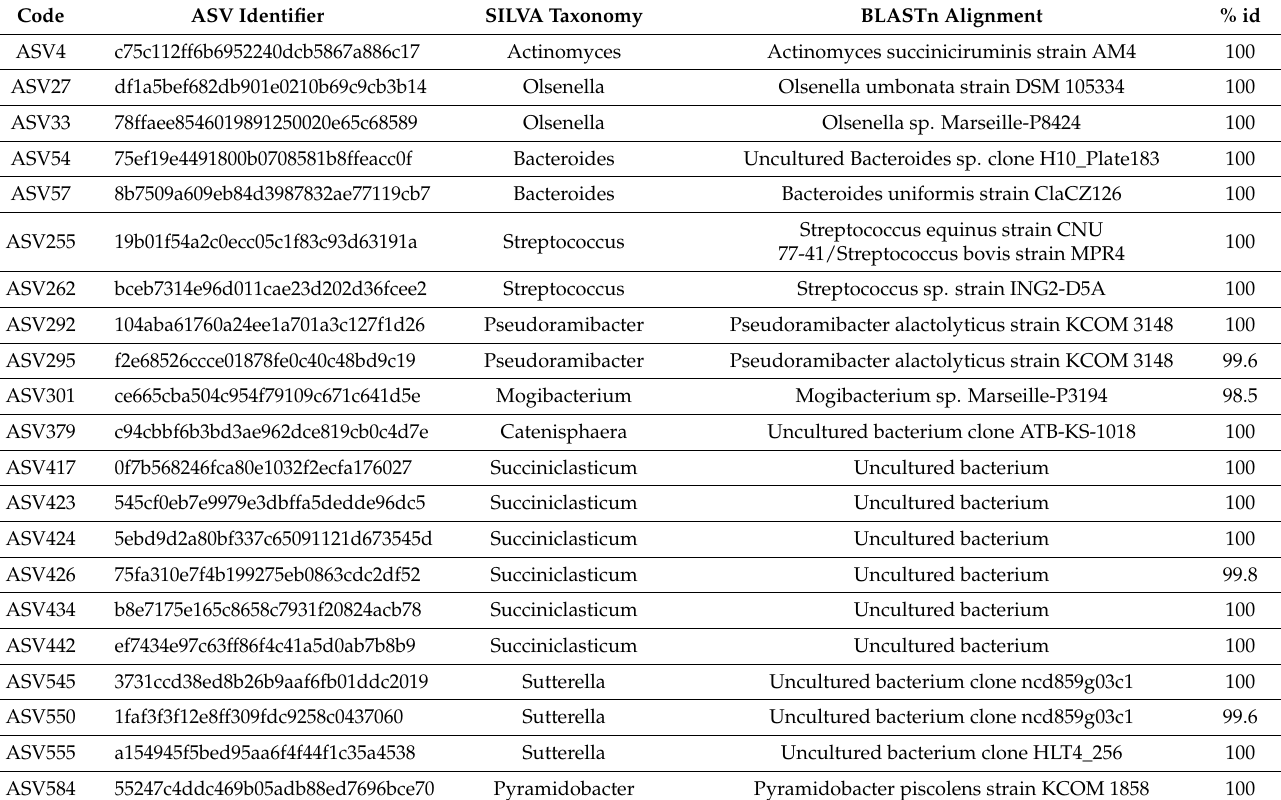
Figure 4. Bubble plot depicting the relative abundance (as % of total reads) of the main ASVs (black circles) and the concentration of propionate, butyrate, valerate and caproate (mg L − 1 ) (white squares) during reactors operation. Table 2. Identifiers, taxonomic affiliation revealed by SILVA database and BLASTn search of the amplicon sequence variants (ASVs) discussed in the